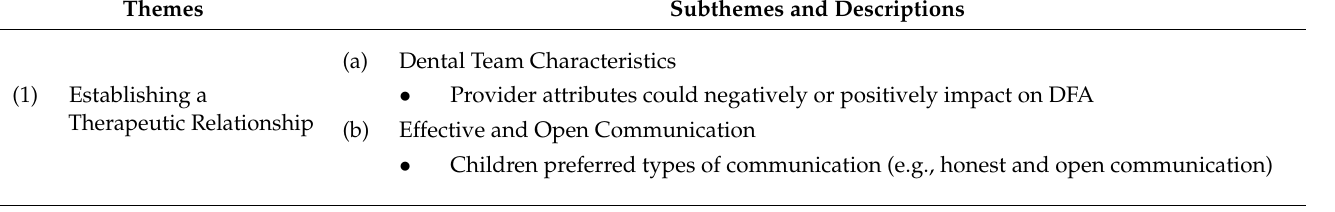
Table 4. Summary of themes and